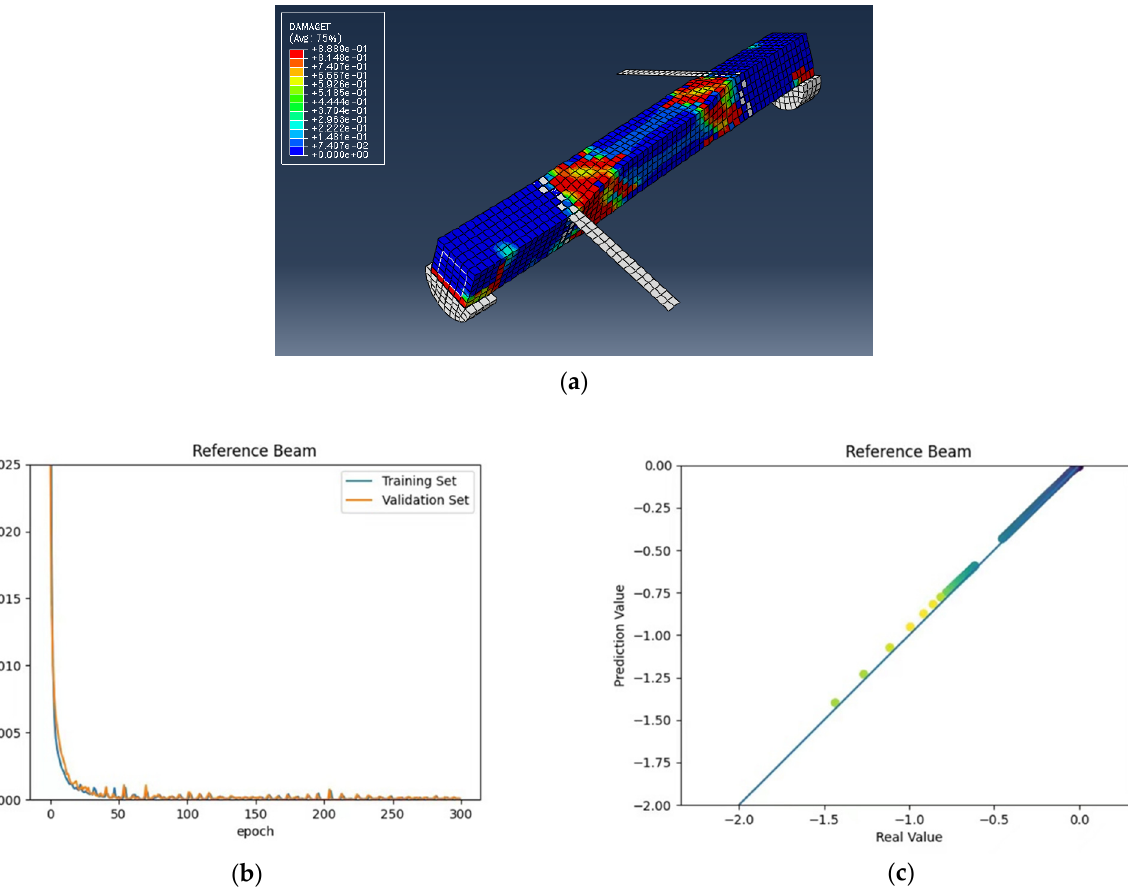
Figure 5. ( a ) Reference beam under combined torsion and bending, ( b ) Training loss, ( c ) Accuracy.